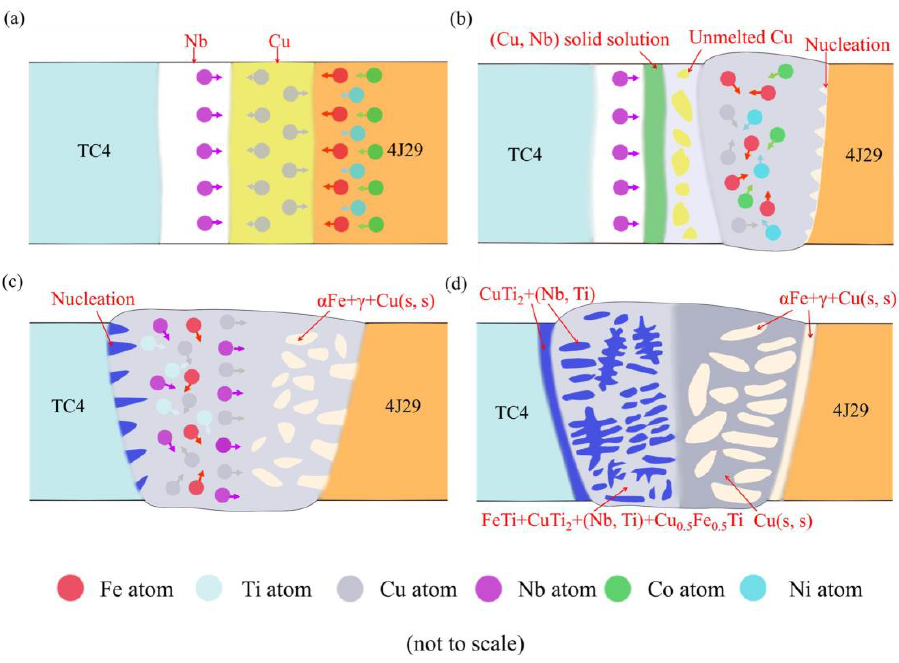
Figure 11. Schematic presentations of the formation process of the TC4/Nb/Cu/4J29 dissimilar welded joints at a welding speed of 10 mm/s, including ( a ) material contact, ( b ) nucleation, and growth of grains of kovar alloy side, ( c ) nucleation and growth of grains of the titanium alloy side, ( d ) the production of IMCs and solid solution in the weld metal.